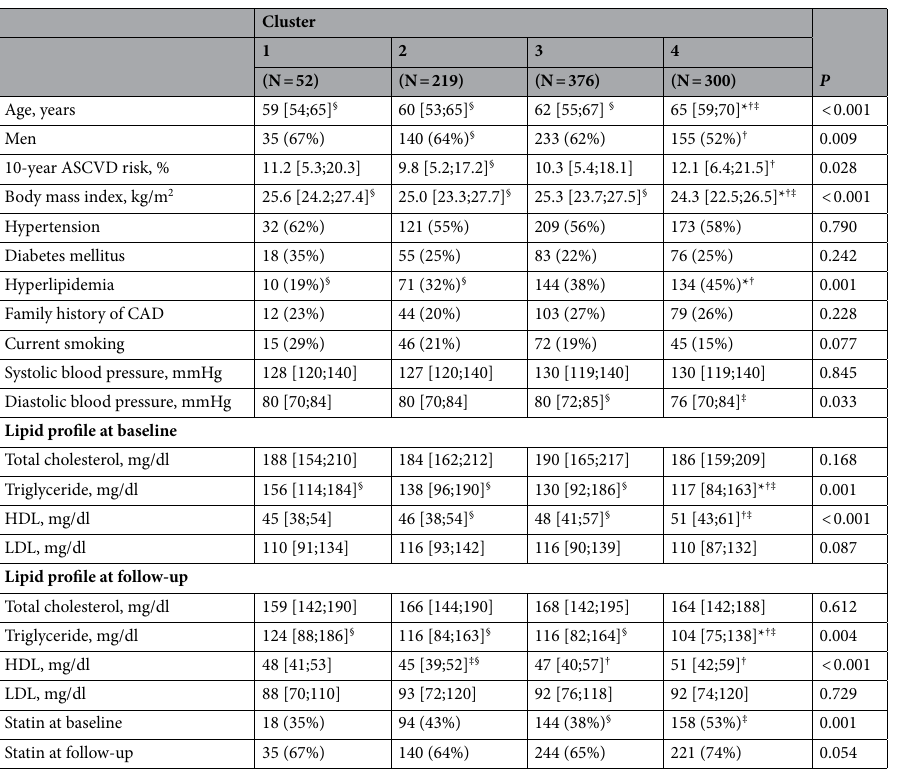
Table 1. Clinical characteristics. Data are presented as the median (interquartile range) for continuous variables and number (percentage) for categorical variables. Adjusted P -values for multiple comparisons < 0.05 are marked as * (vs. Cluster 1), † (vs. Cluster 2), ‡ (vs. Cluster 3), and § (vs. Cluster 4). ASCVD = atherosclerotic cardiovascular disease, CAD = coronary artery disease, HDL = high-density lipoprotein, LDL = low-density